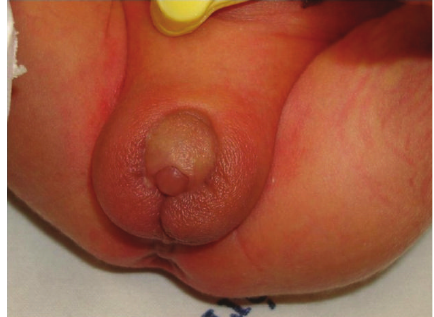
Figure 3: Penoscrotal hypospadia confirmed by clinical examina- tion performed afterbirth with bifid scrotal